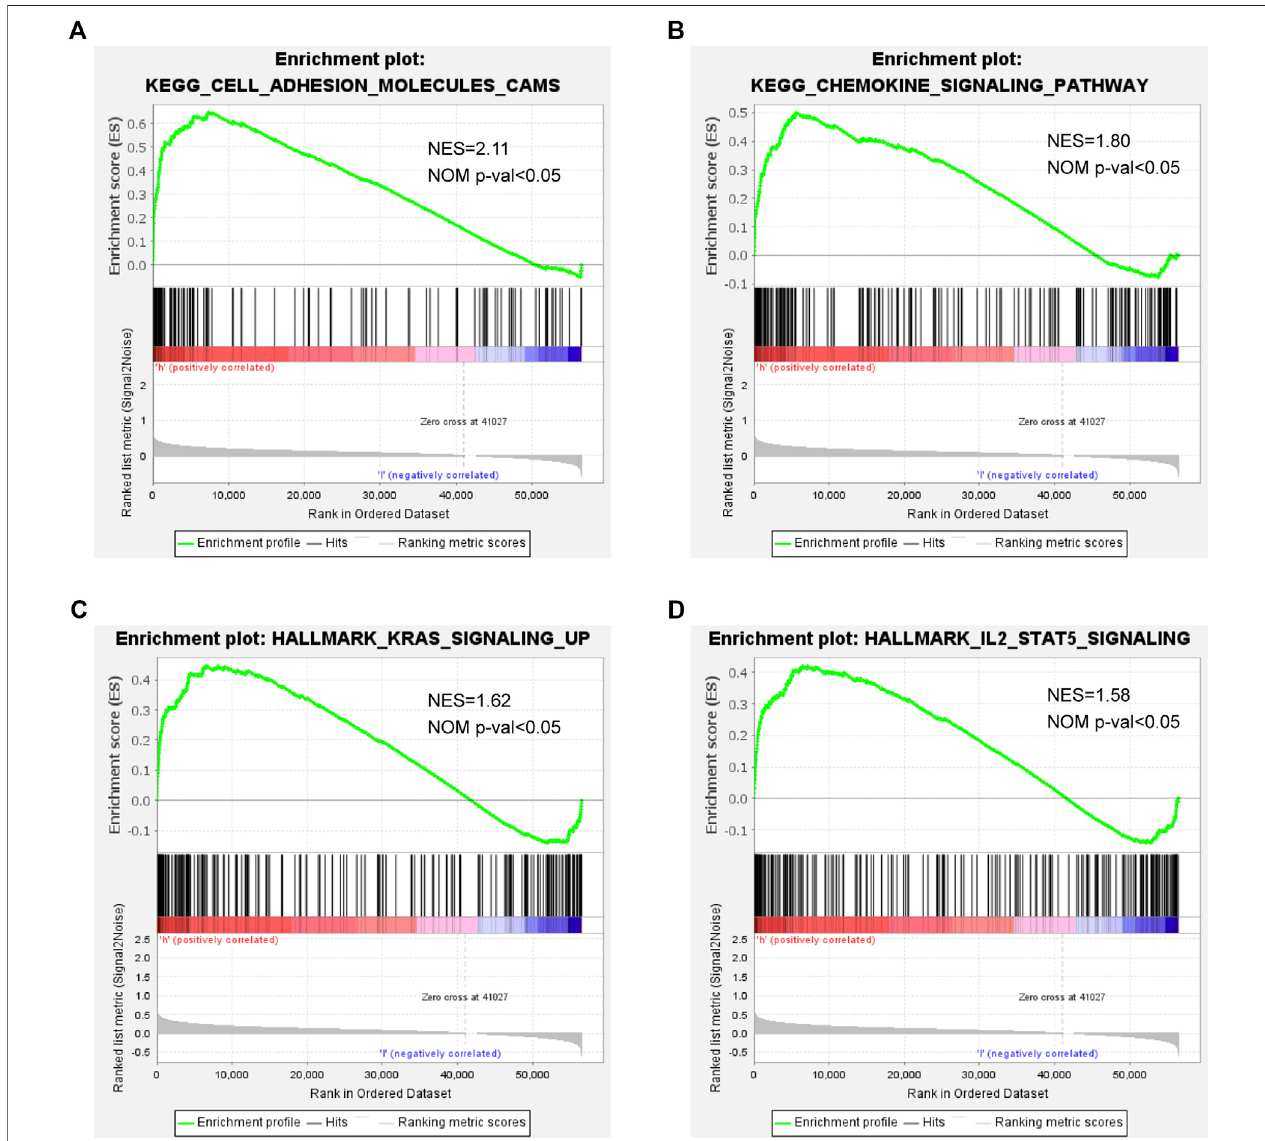
FIGURE 5 | GSEA in high- and low-risk patients: (A) adhesion molecules, (B) chemokine signaling pathway, (C) KRAS signaling, and (D) IL-2/STAT5 signaling.